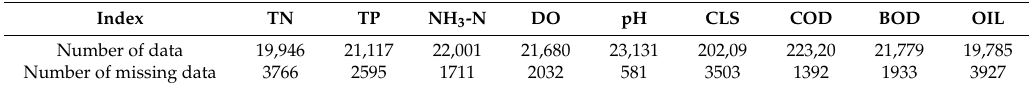
Table 1. The statistics for each water